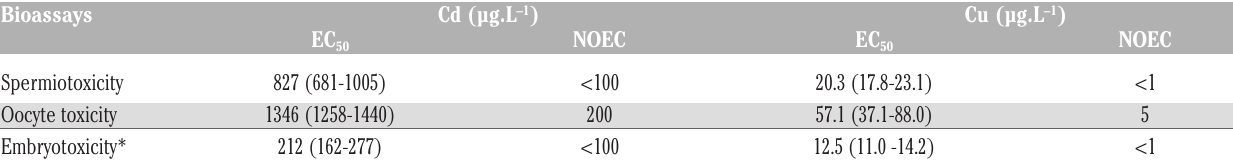
Table 2. Mean effective concentrations (EC ) and their 95% coefficients of variation, and non-observed effect concentration (NOEC) 50 values for different toxicity assays with C. gigas for cadmium and copper. Less than (<) values are given for cases where NOEC could not be calculated.